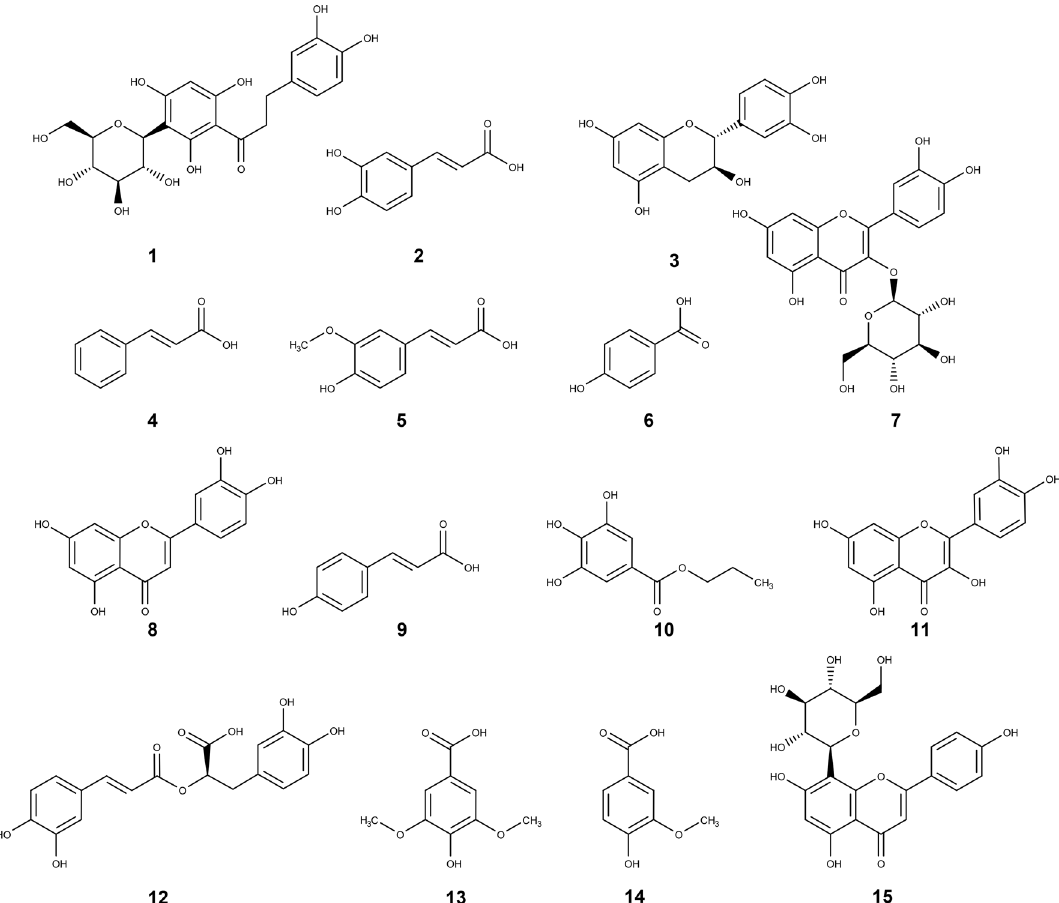
Figure 1. Compounds identified and quantified in the ethanolic extract of Aspalathus linearis using Ultra- Performance Liquid Chromatography—Quantitative Time of Flight analysis, namely aspalathin ( 1 ), caffeic acid ( 2 ), (+)-catechin ( 3 ), cinnamic acid ( 4 ), ferulic acid ( 5 ), 4-hydroxy benzoic acid ( 6 ), isoquercitrin ( 7 ), luteolin ( 8 ), p-coumaric acid ( 9 ), n -propyl gallate ( 10 ), quercetin ( 11 ), rosmarinic acid ( 12 ), syringic acid ( 13 ), vanillic acid ( 14 ) and vitexin ( 15